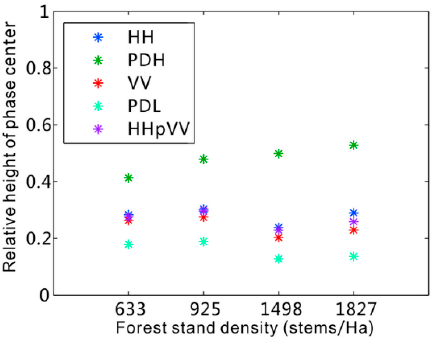
Figure 8. Relative height of phase centers for different density.